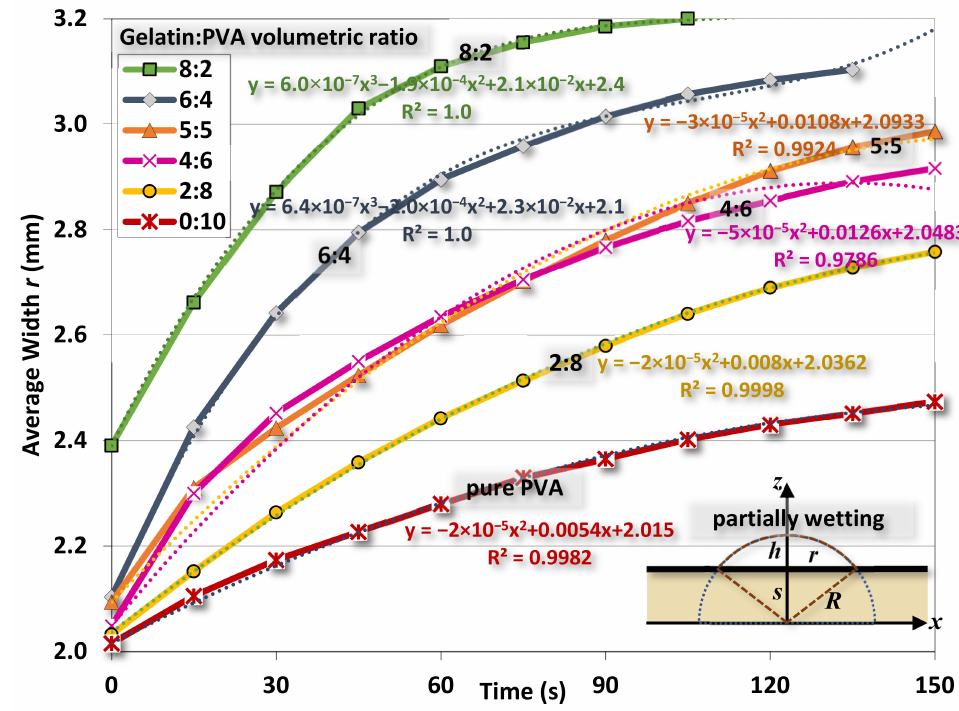
Figure 15. Variations of the width r of water contact as functions of time.